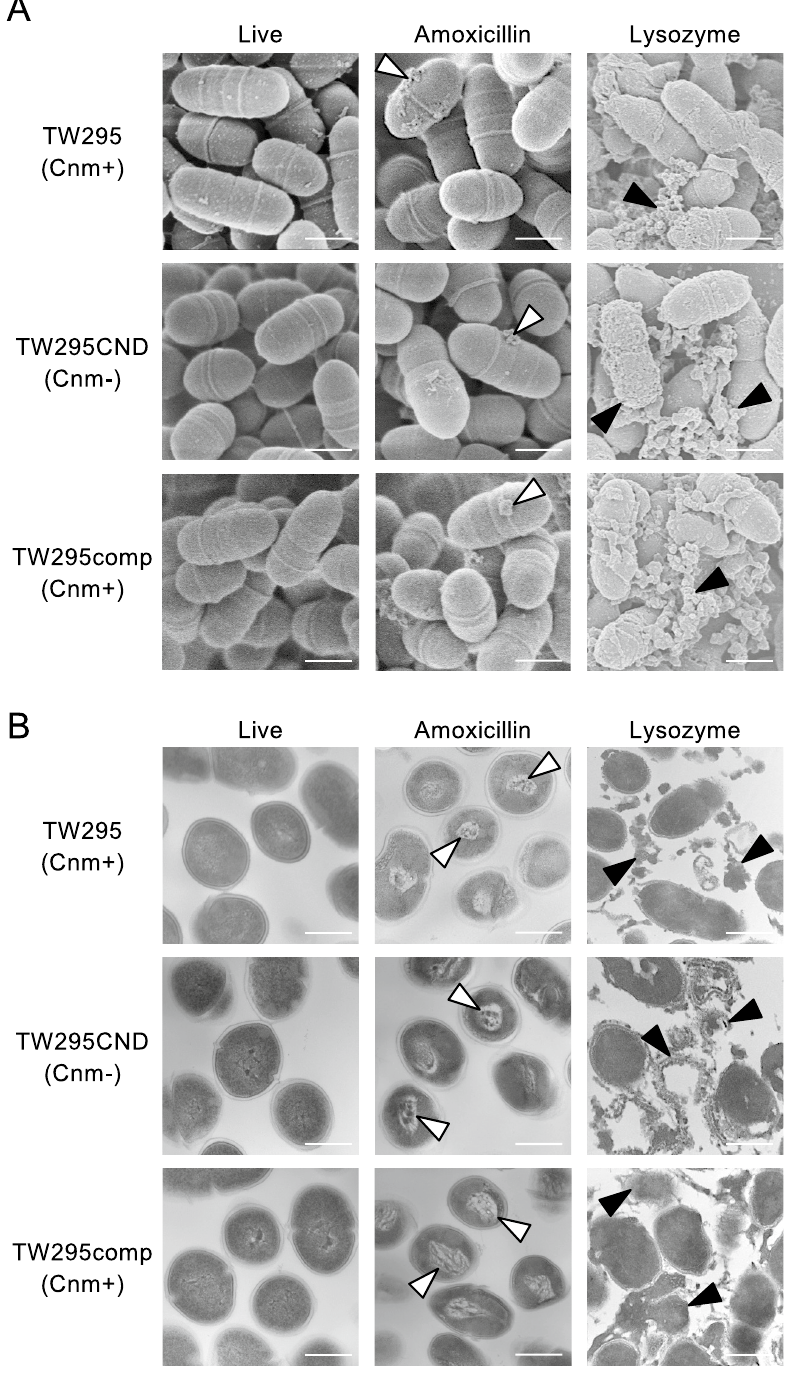
Figure 1. Representative electron microscopy images of live S. mutans , amoxicillin-killed S. mutans , and lysozyme-killed S. mutans . ( A ) Scanning electron microscopy images. Scale bar, 500nM. White and black arrowheads indicate damage to the bacterial cell surface layer and lysis of the bacteria, respectively. ( B ) Transmission electron microscopy images. Scale bar, 500 μm. White and black arrowheads indicate abnormal changes in the cytoplasm and lysis of the bacteria,